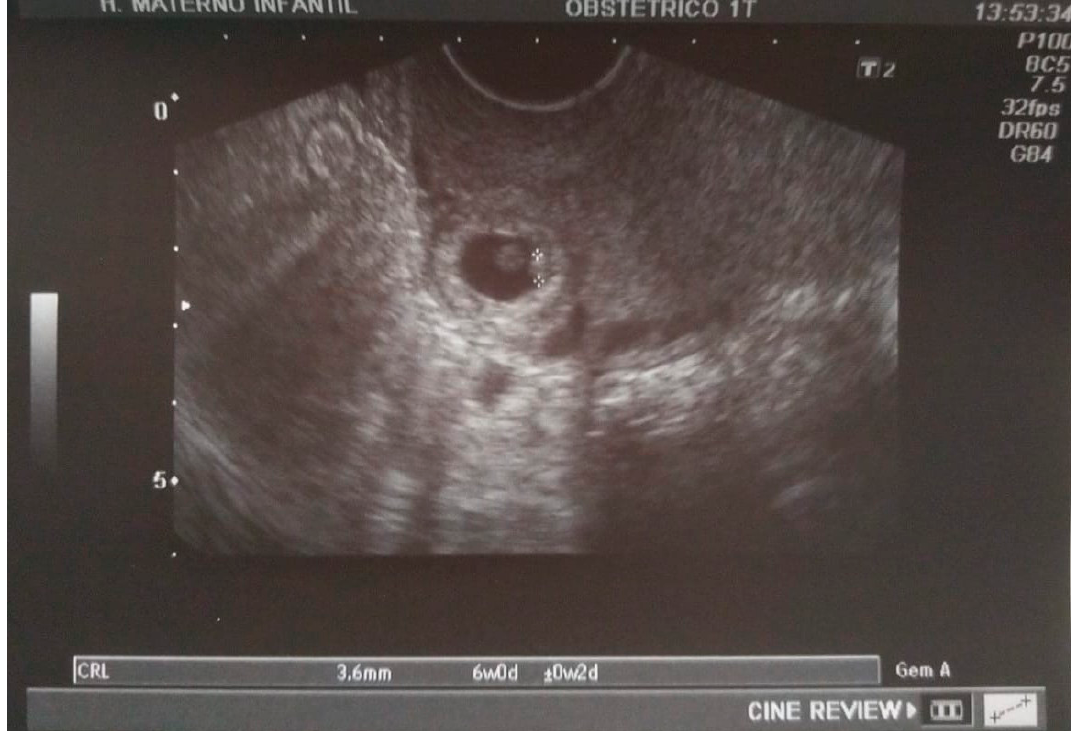
Figure 2. A sagittal transvaginal image showing a gestational sac implanted in the scar area of the previous cesarean with a 3.6 mm embryo.